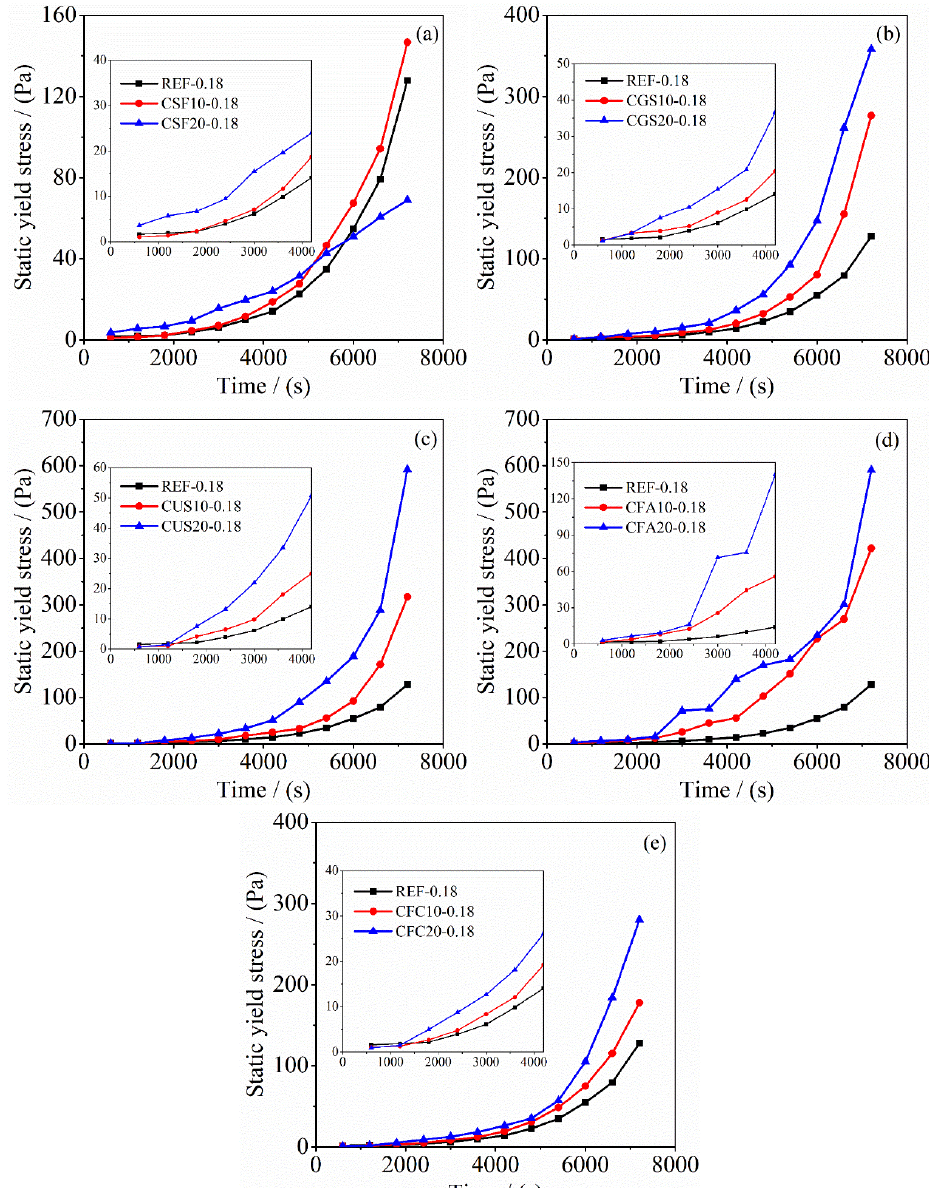
Figure 12. Effect of mineral admixtures on the evolution of the static yield stress of UHPC-based pastes: ( a ) CSF-0.18, ( b ) CGS-0.18, ( c ) CUS-0.18, ( d ) CFA-0.18, ( e ) CFC-0.18.